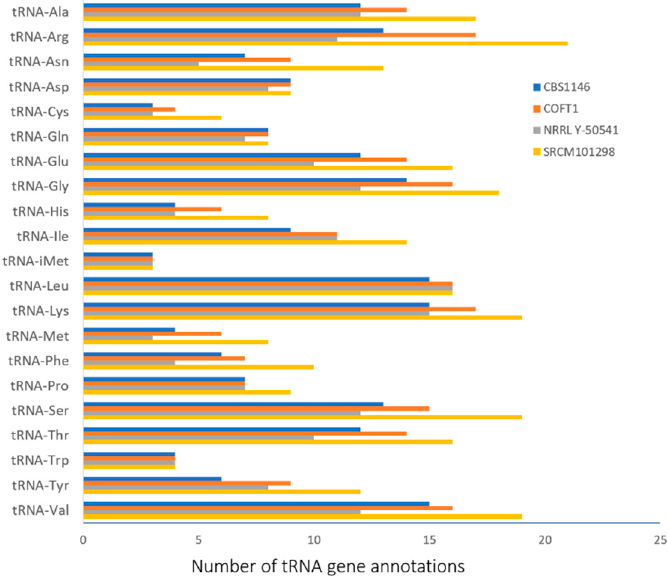
Figure 1. Total number of tRNA gene annotations obtained with the YGAP pipeline for the four Torulaspora delbrueckii strains.